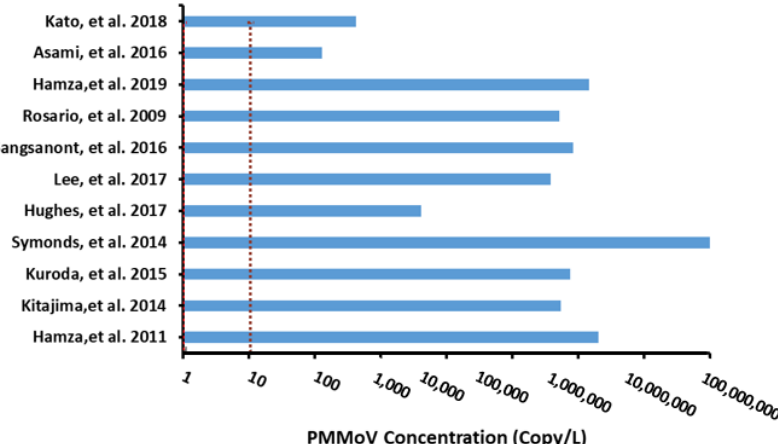
Figure 3. PMMoV abundance in wastewater treatment plants (WWTPs) [144,145,150,152,154,175–180]. PMMoV persistence in WWTPs’ effluents: red dashed line denotes LOD of PMMoV (0.66–1.3 copies. L − 1 ) in large scale samples whereas brown dashed line refers to LOQ for the same sample size (7.0 – 14 copies. L −1 ) [150].